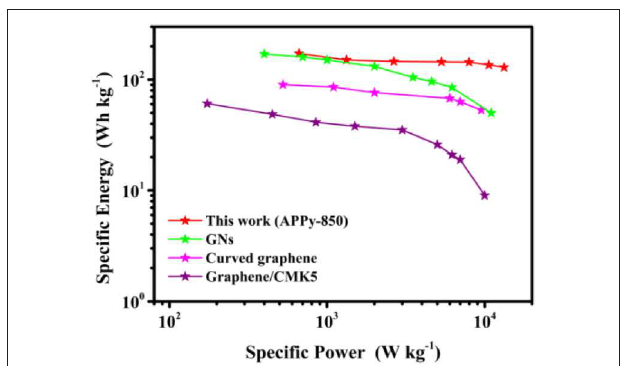
FIGURE 6 | Ragone plots of APPy-850–based electrode compared with those of typical cathode materials based on 1-ethyl-3-methylimidazolium tetrafluoroborate (EMIMBF 4 ) electrolytes (Liu et al., 2010; Lei et al., 2013; Gao et al.,